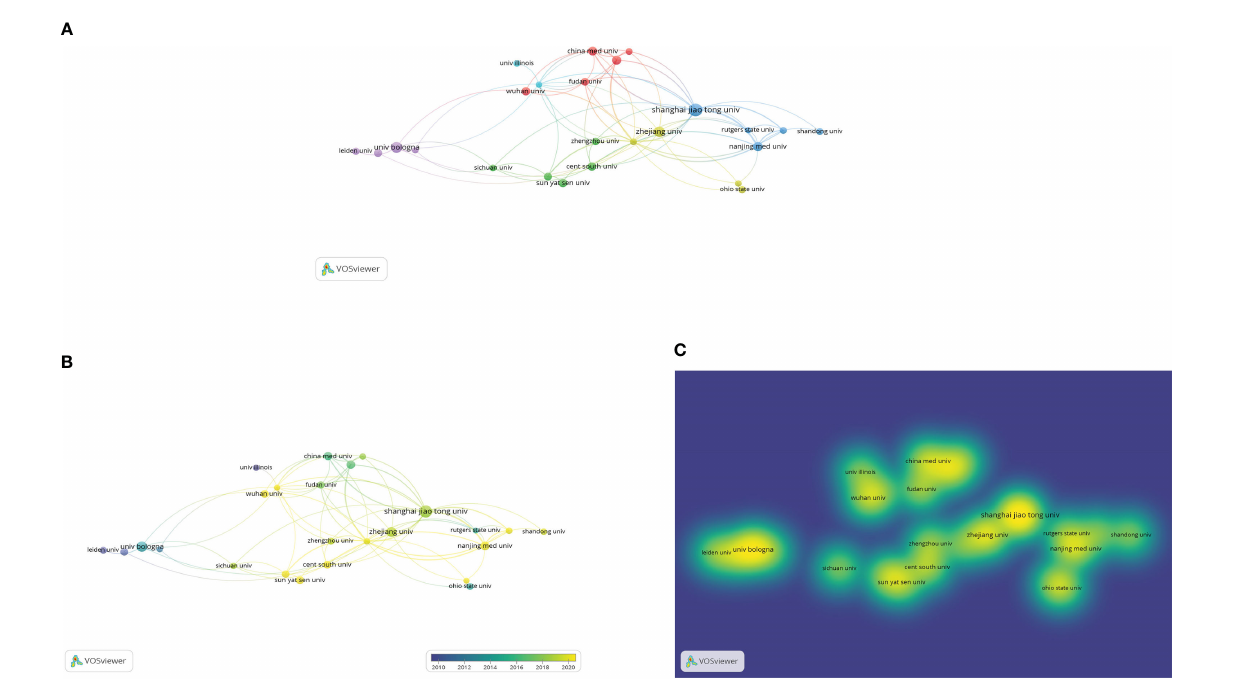
FIGURE 5 Global partnerships between institutions in the fi eld of osteosarcoma metabolism. (A-C) are the network of connections between institutions, the graph of author ’ s hotness over time, and the graph of author ’ s density,